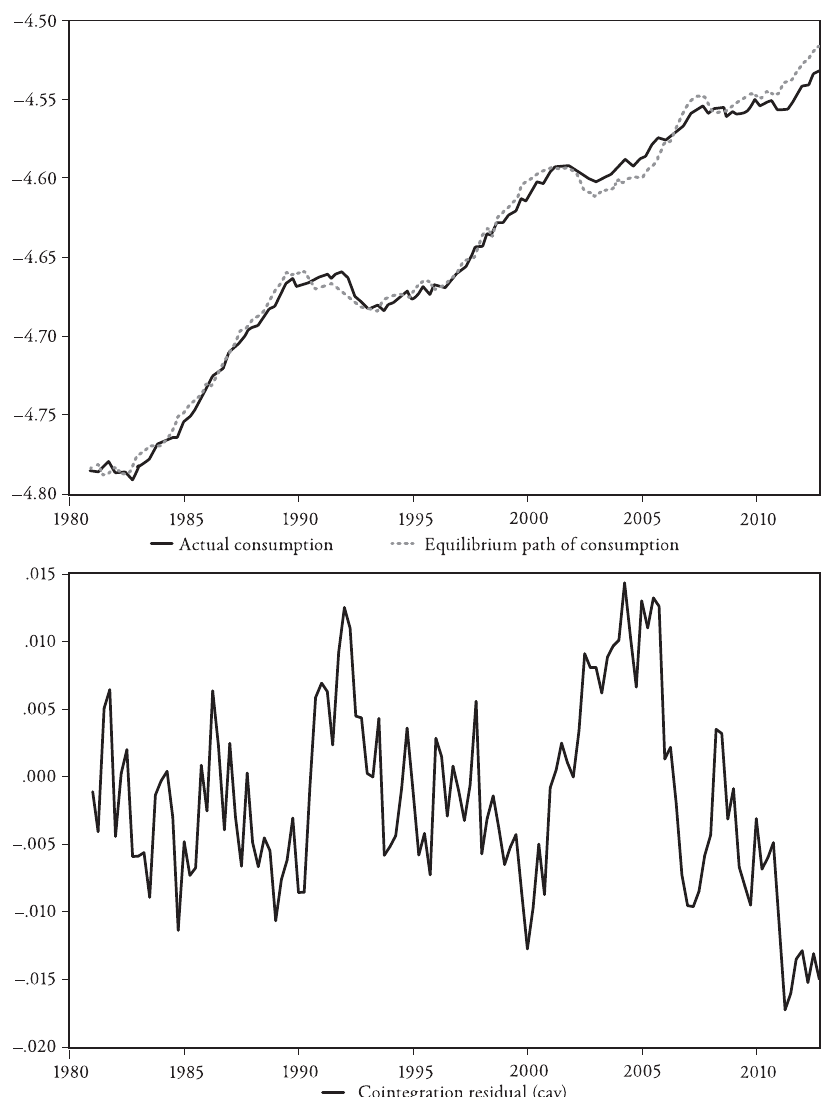
Figure 7: The Cay Residual Based on the 1981-2001 Cointegrating